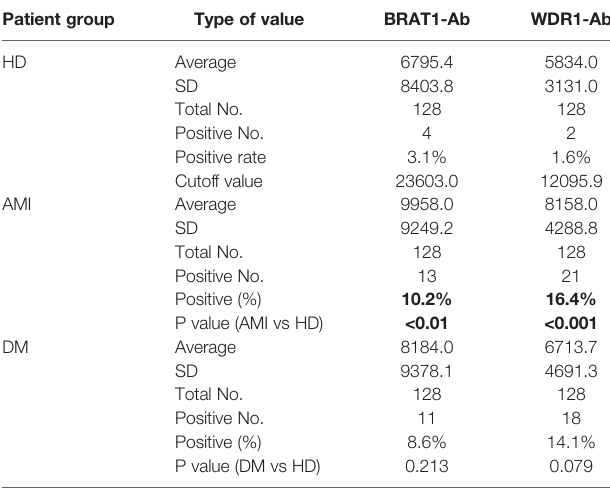
TABLE 3 | Comparison of serum BRAT1-, and WDR1-Ab levels between HDs and patients with AMI or DM tested by AlphaLISA. Patient